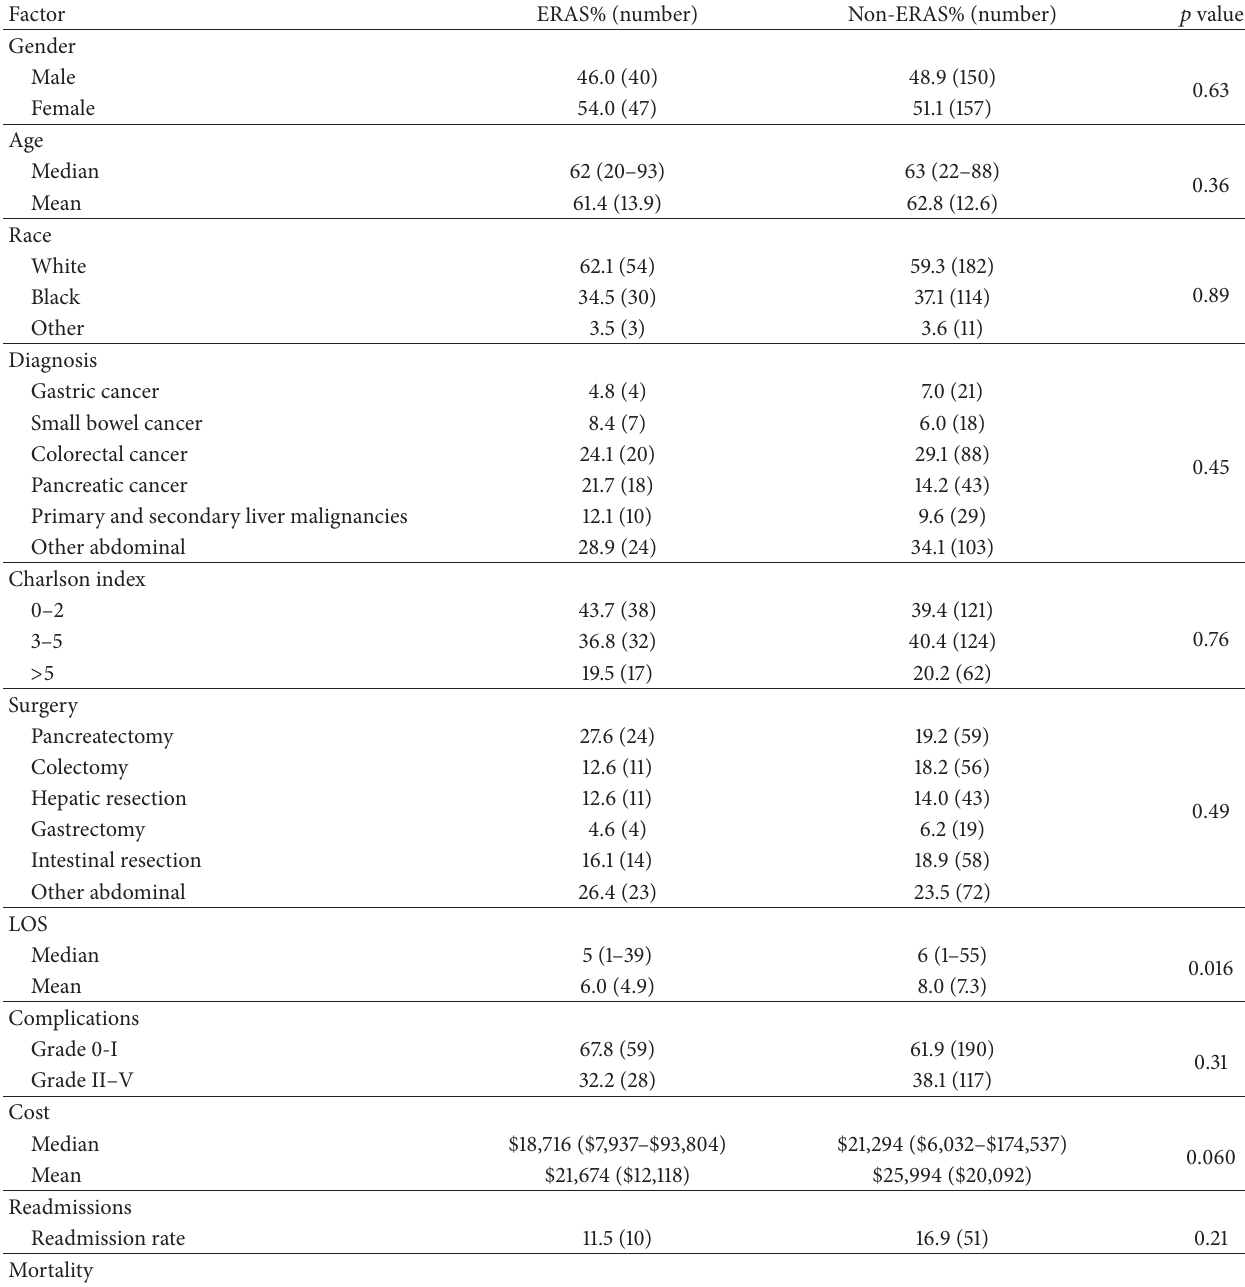
Table 3: ERAS versus non-ERAS (control) patients on a single surgical unit,